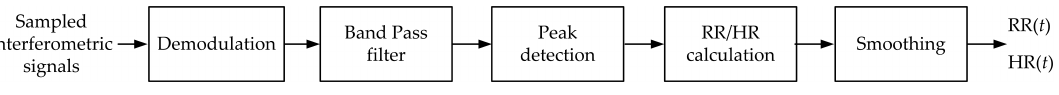
Figure 4. The signal processing from the FOI probe to determine the respiratory rate (RR) and the heart rate